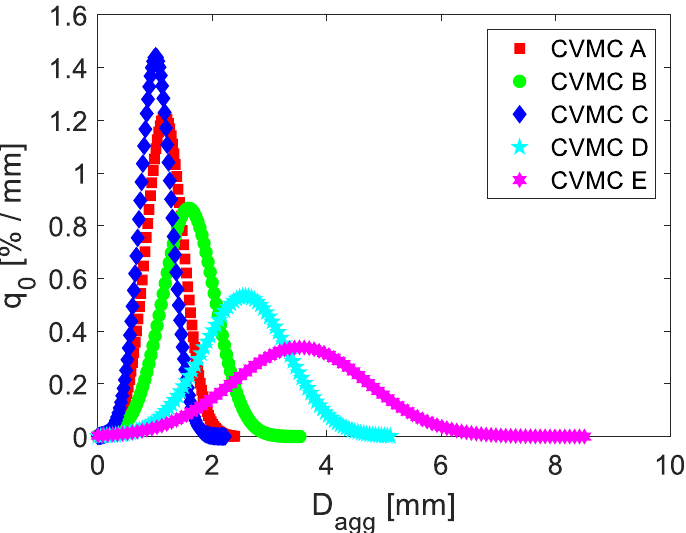
Figure 10. PSD after 10 min for various experiments when simulated by employing the CVMC